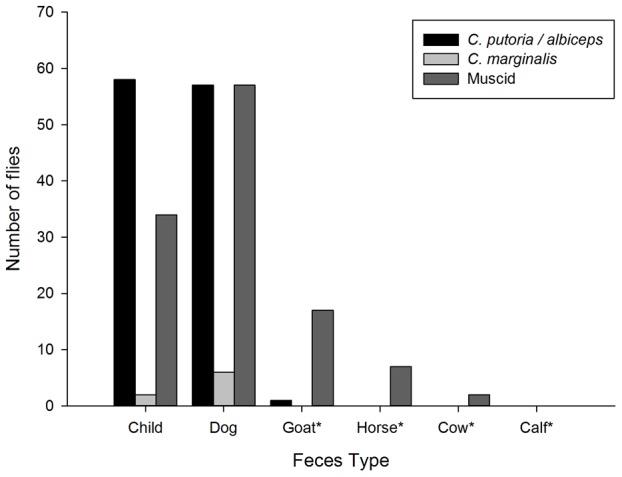
Relative attractiveness of different feces to flies.Where *Indicates a significant difference between the attractiveness of human feces and other media.